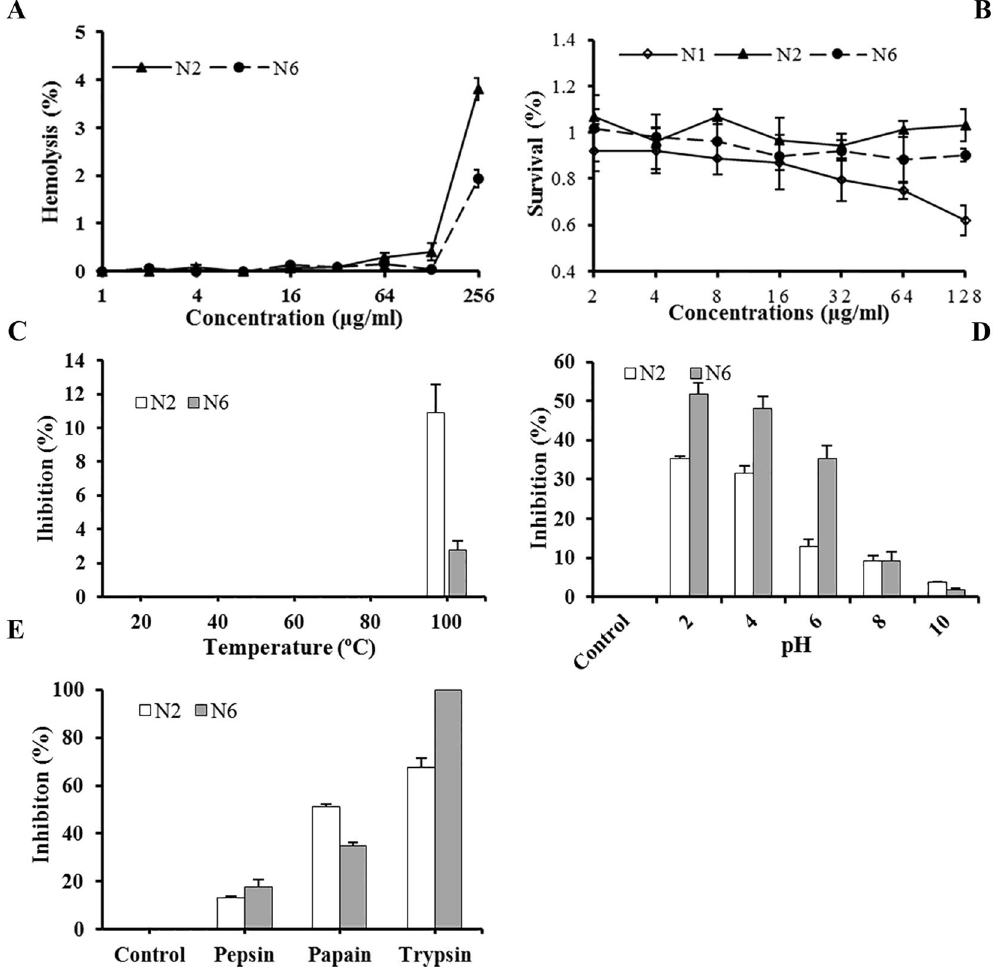
Figure 1. Hemolytic activity, cytotoxicity and stability of N2 and N6. ( A ) Hemolytic activity of N2 and N6 against murine erythrocytes. ( B ) Cytotoxicity of the peptides against RAW264.7 cells. ( C , D , E ) The effects of temperature ( C ), pH ( D ) and proteases ( E ) on the antibacterial activity of N2 and N6 in vitro against S . enteritidis CVCC3377 cells. The results are given as the mean ± SEM (n =